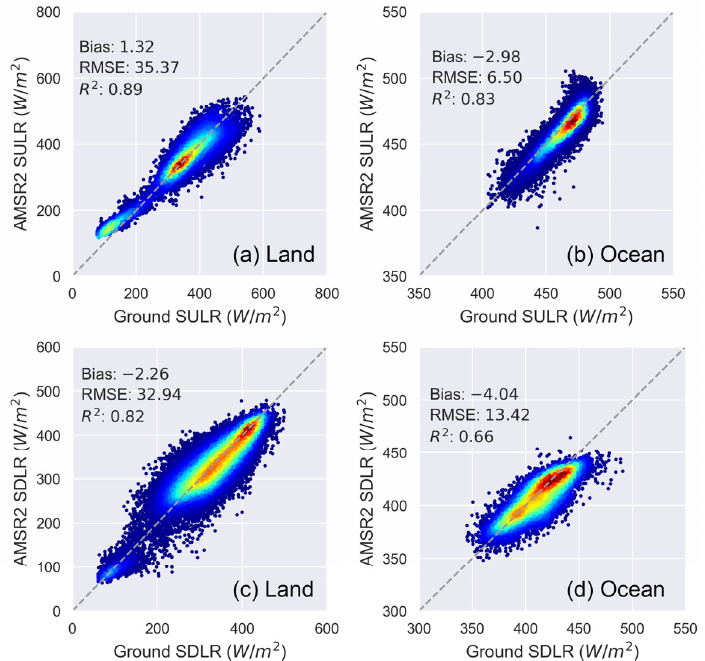
Figure 8. Validations for ( a ) surface upward longwave radiation (SULR) and ( c ) surface downward longwave radiation (SDLR) derived from the Advanced Microwave Scanning Radiometer 2 (AMSR2) using Baseline Surface Radiation Network (BSRN) measurements and for ( b ) SULR and ( d ) SDLR derived from the AMSR2 using the Global Tropical Moored Buoy Array (GTMBA) measurements. The color indicates the density of sampling points, with higher density in red and lower density in blue.